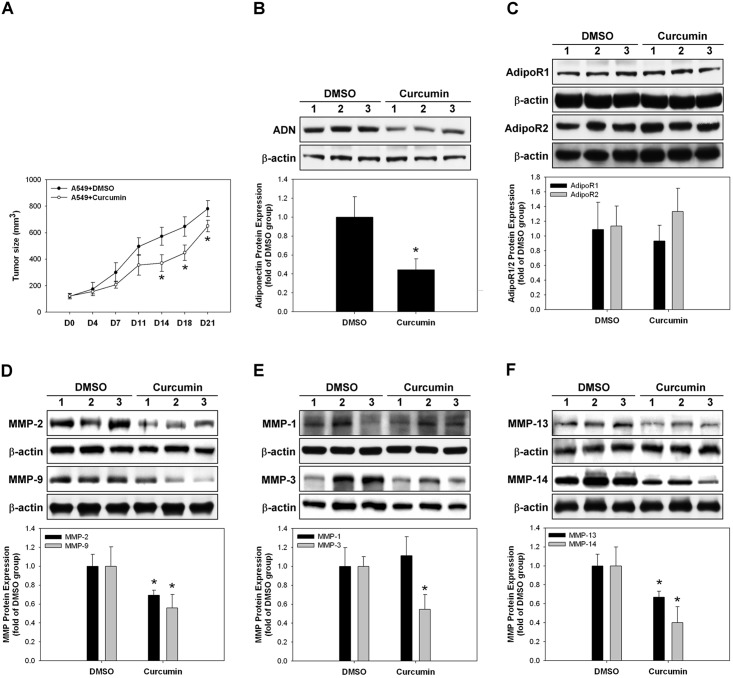

In vivo effect of curcumin on the expression of adiponectin and matrix metalloproteinases (MMPs).
(A) The tumor sizes of curcumin-treated mice were decreased significantly compared to those of the control group after 14 days. (B) Tumor adiponectin expression of curcumin-treated mice was decreased significantly compared to that of the control group. (C) Expression of both adiponectin receptor 1 and receptor 2 in the curcumin-treated mice did not change in vivo. (D–F) Expression levels of MMP-2, -9, -3, -13, and -14 were decreased with curcumin treatment in vivo. MMP-1 expression was not altered.